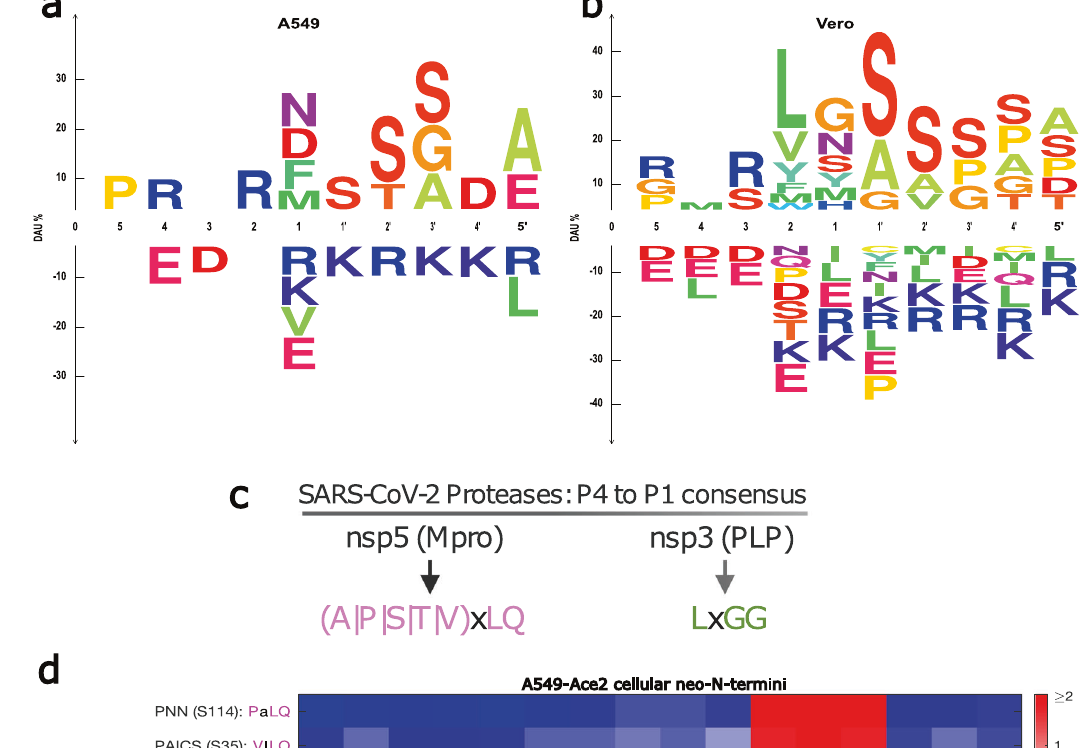
Finally, we performed gene ontology analysis of proteins from which the signi fi cantly regulated neo-N-termini were derived, identifying signi fi cantly regulated biological functions, cellular compartments and molecular functions within each cell line dataset Supplementary Fig. 11, Supplementary Fig. 12. While many of the enriched GO terms were unique to each cell line,